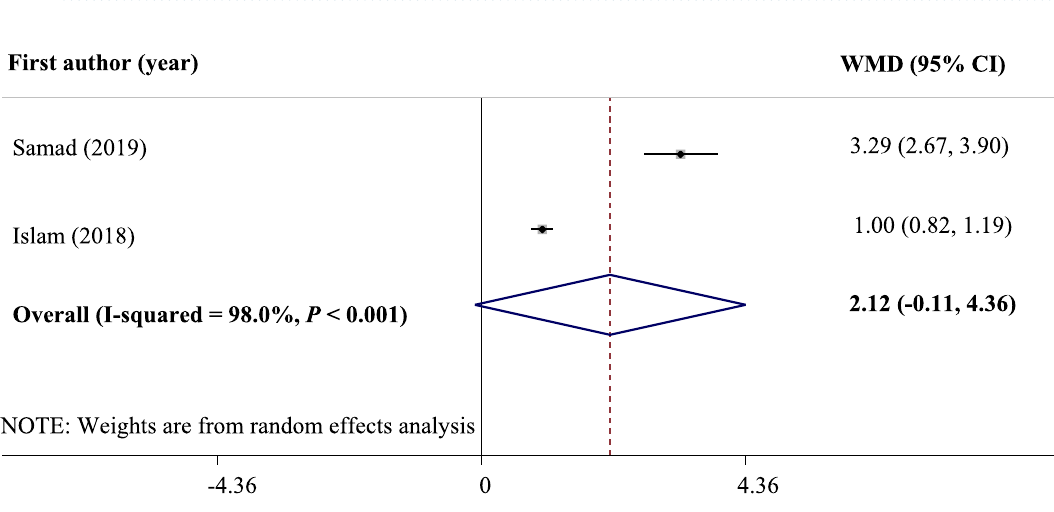
Figure 3. Forest plot of the comparison of serum selenium levels between depressive patients and healthy